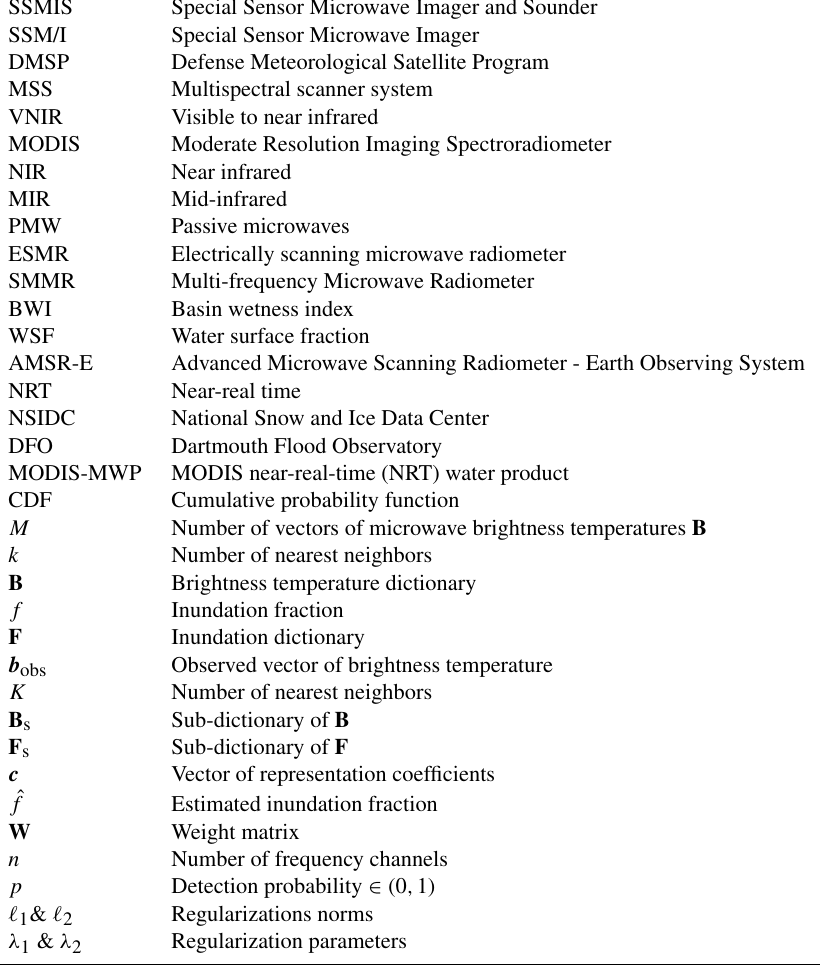
Table B1. Acronyms and